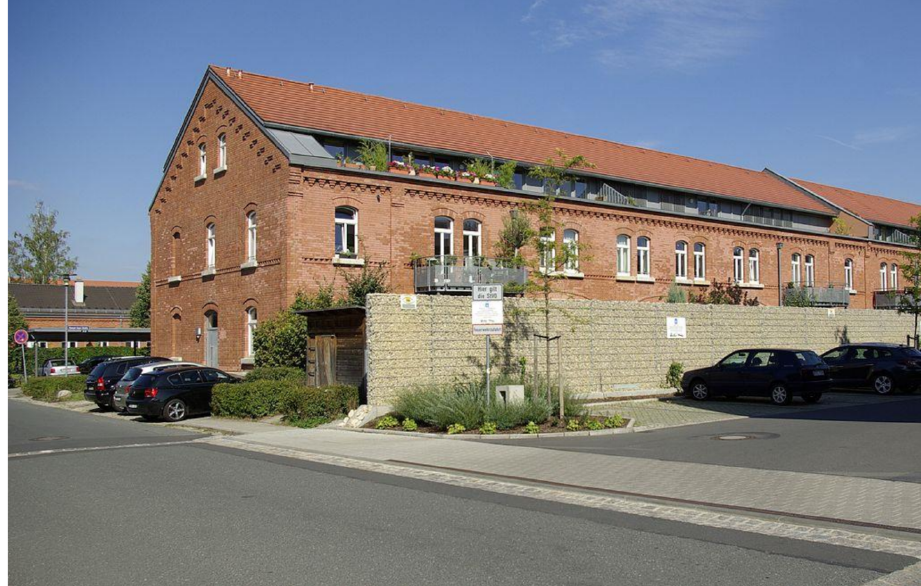
Figure 16. Erlangen, apartments in barracks (source: https://onlinestreet.de/strassen/Paul-Gordan- Stra%C3%9Fe.Erlangen.245966.html#&gid=1&pid=1 (accessed on 30 December 2021), author Janeri- cloebe/ CC BY